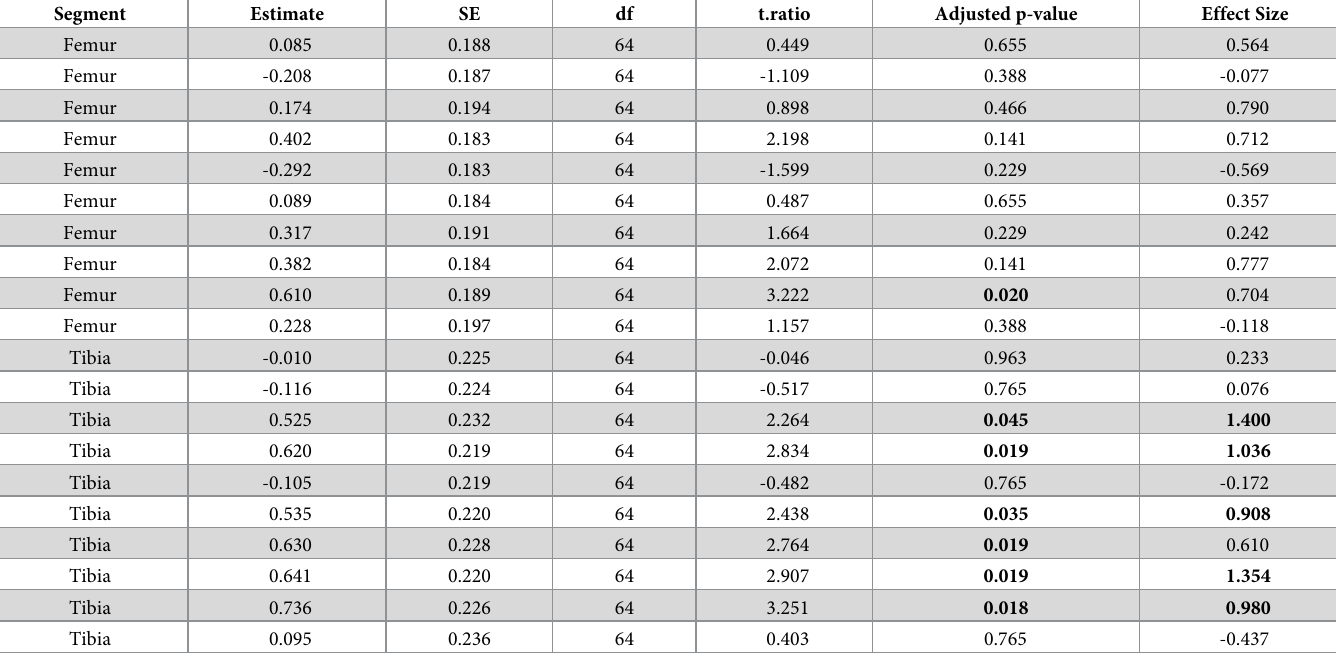
Table 6. Changes from baseline (Week 12 –Week 0) for the femur and tibia. Segment